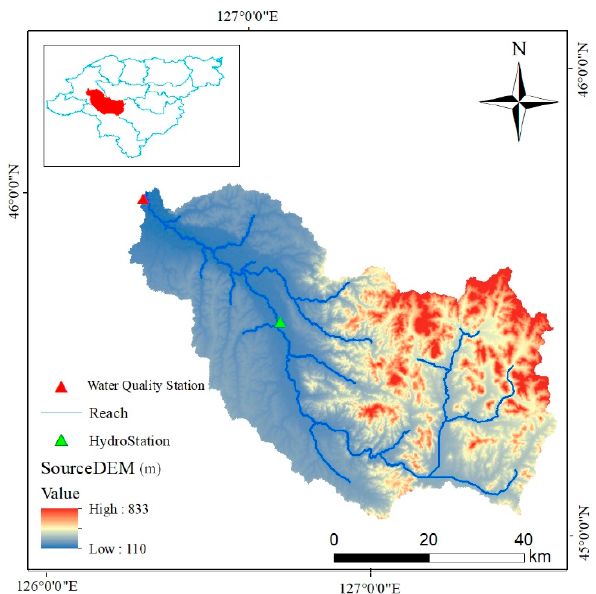
Figure 1. Topographic map of the study area location.